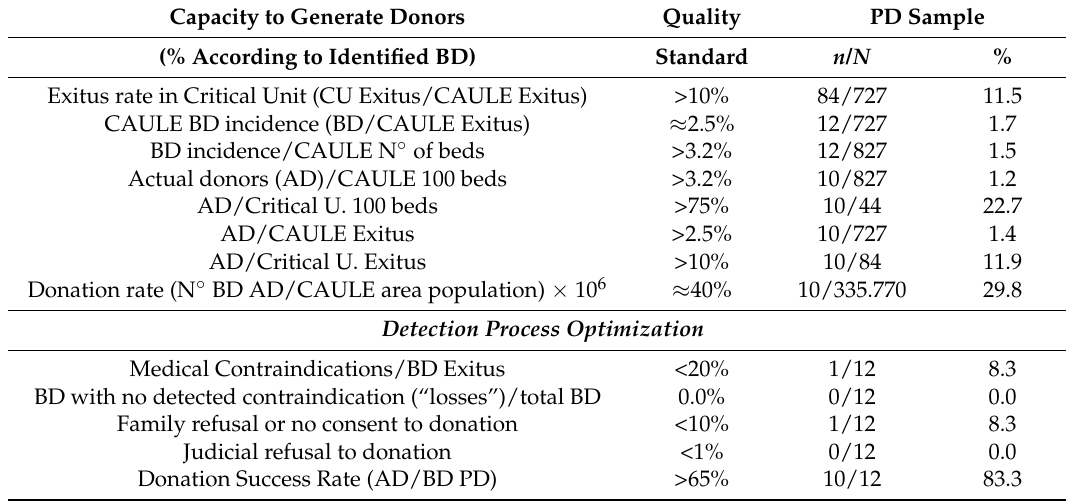
Table 6. Quality indicators in the donation process